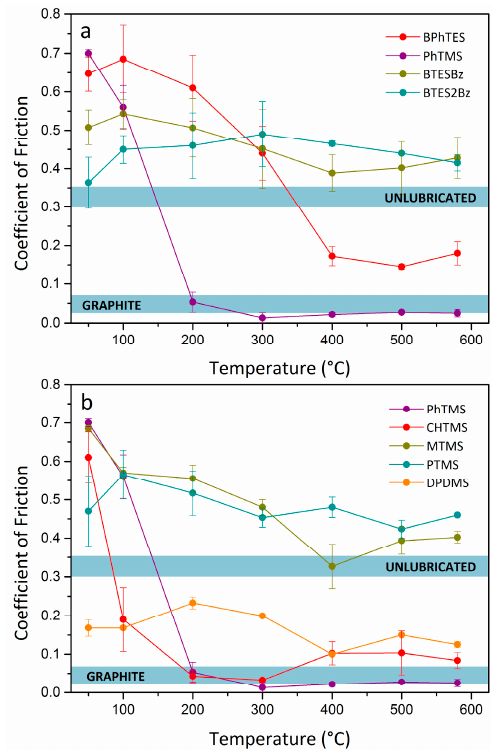
Figure 1. Friction coefficients of the organosilica networks. The figure displays the coefficients of friction (CoF) obtained by high temperature pin-on-disc measurements on films of organosilica powders prepared from suspensions: ( a ) Polymers obtained from monomers with terminal and bridging organic groups; ( b ) Polymers obtained from monomers with different terminal organic groups. Reference CoF of the unlubricated metal-metal contact and a graphite film are included. The CoF of the organosilica materials were compared with the CoF of the unlubricated metal-metal contact, and a film of the state-of-the-art lubricant graphite. For the sake of clarity and simplicity, the data points of both reference measurements are presented in the form of a colored band. The actual